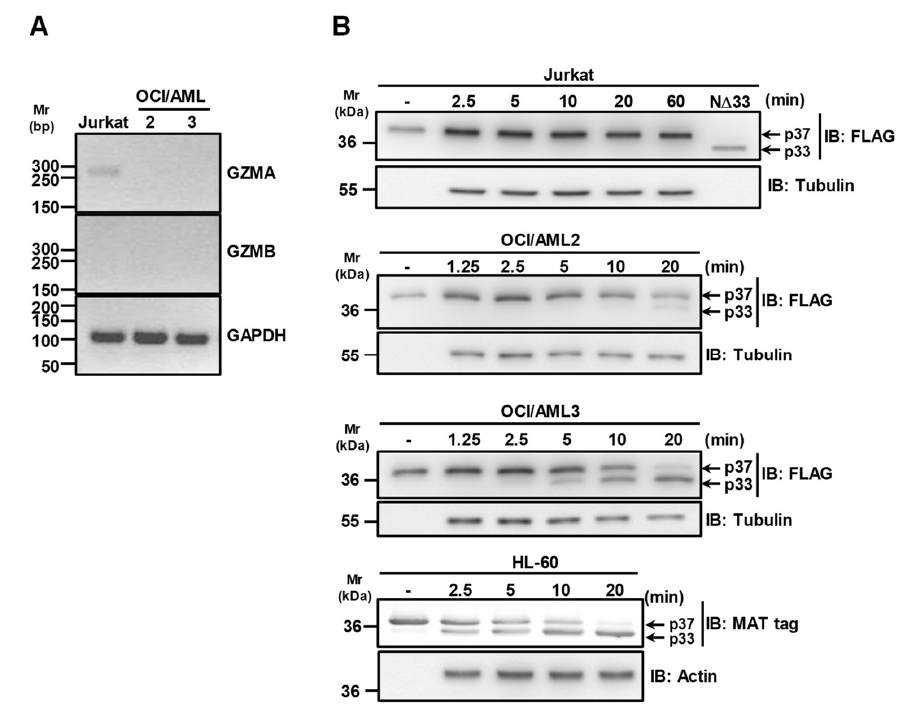
Figure 3. Granzymes A and B are not responsible for APE1 cleavage in OCI/AML cells. ( A ) Granzymes A and B are not expressed in OCI/AML cells. Granzyme A (GZMA) and B (GZMB) expression in OCI/AML2 and OCI/AML3 cell lines were assayed by PCR. Jurkat cDNA was used as positive control.